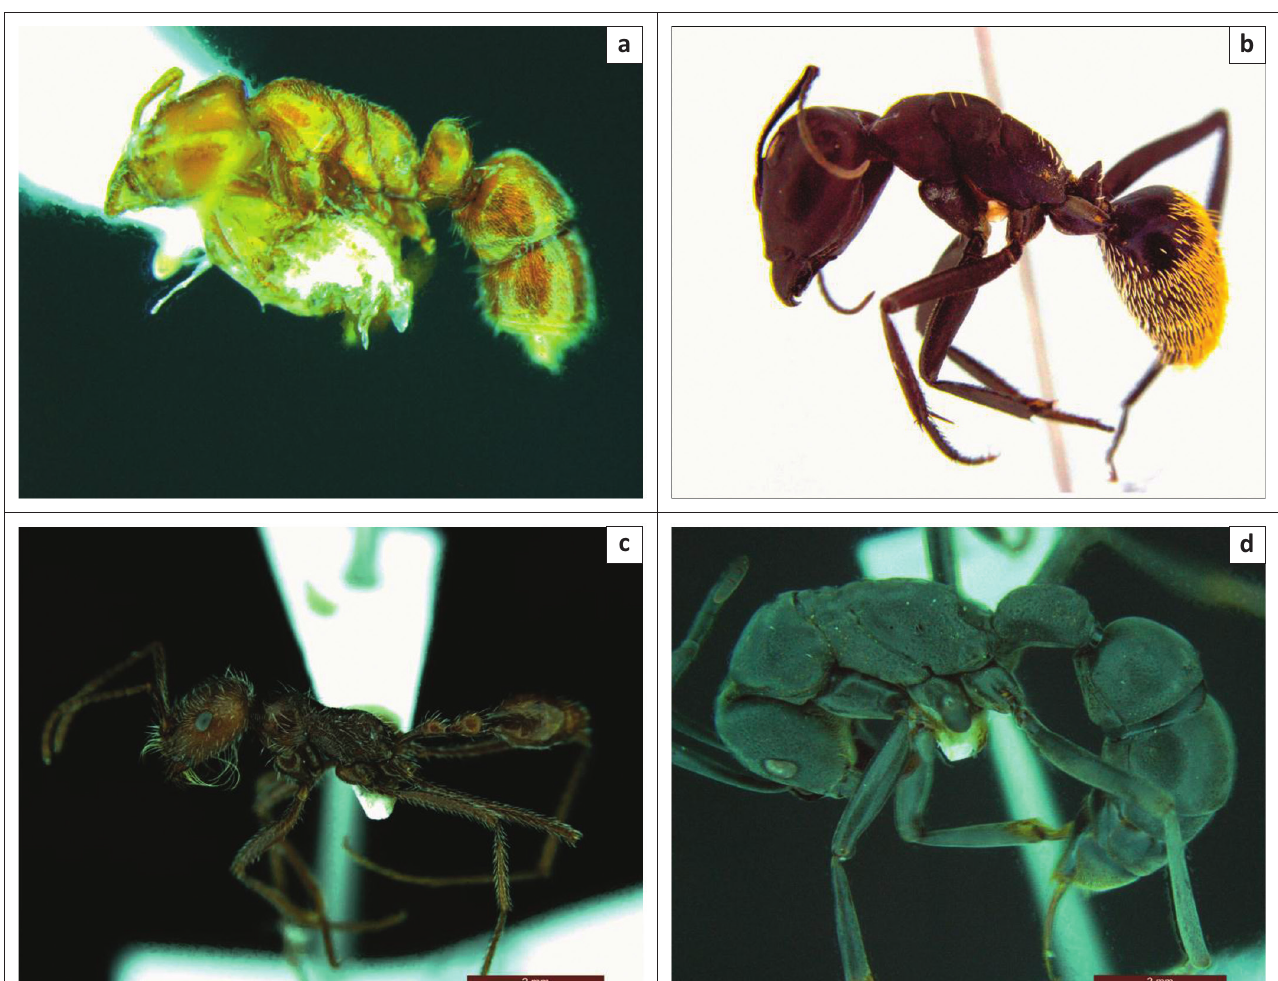
FIGURE A1: Images of some notable and interesting species collected during 13 surveys: (a) Introduced species Ponera UOVC_01, (b) Camponotus fulvopilosus De Geer, (c) Ocymyrmex flaviventris Santschi and (d) Platythyrea lamellosa